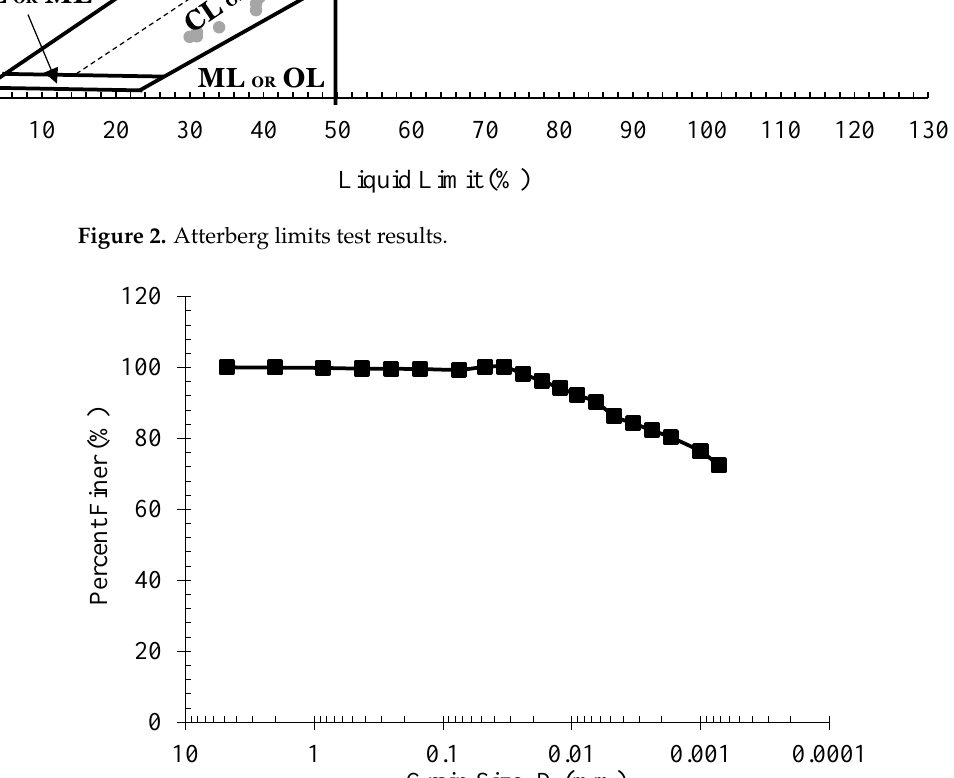
Figure 2. Atterberg limits test results.